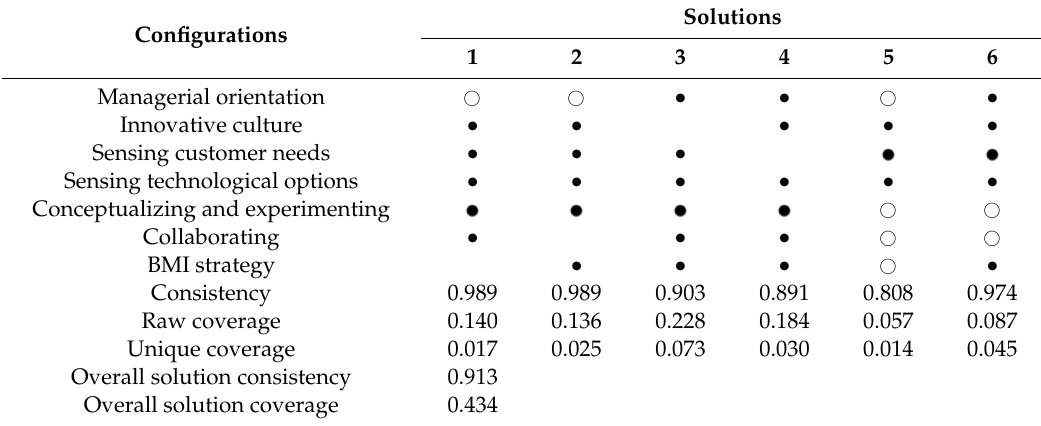
Table 5. FsQCA: Configurations for BMI in established